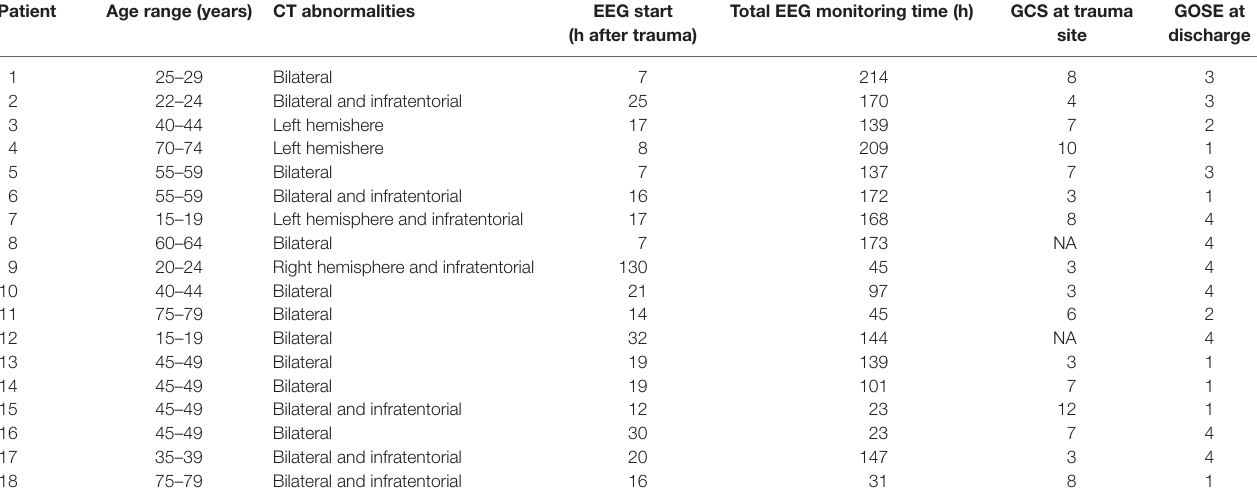
TaBle 2 | Baseline characteristics and outcome of patients with acute traumatic brain injury. Patient age range (years) cT abnormalities